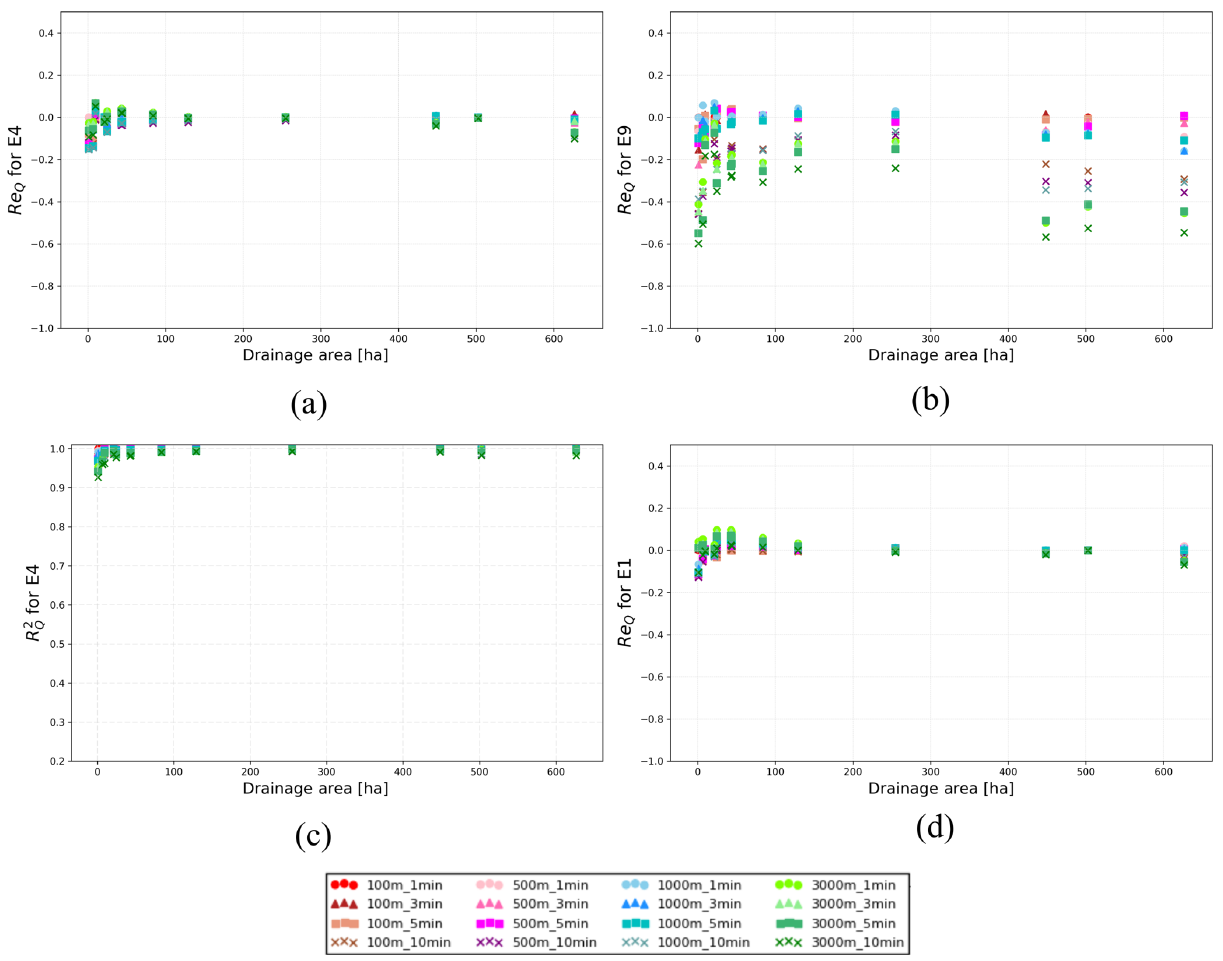
Figure 7. Relative error in peak Re Q and coefficient of determination R 2 rainfall input resolutions. Two different events are presented: E4, a low-intensity constant event, and E9, a multiple-peak